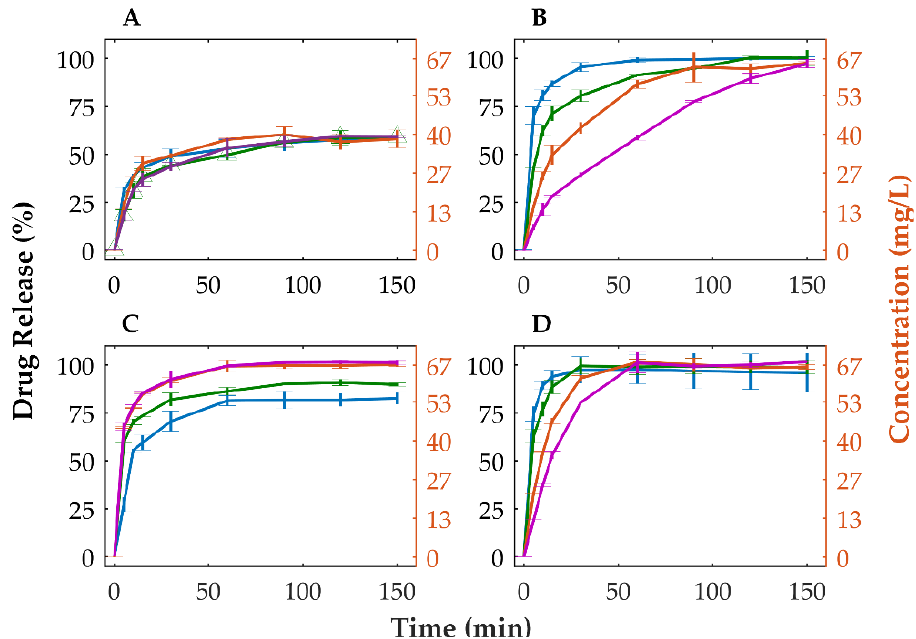
Figure 4. Dissolution profiles of crystalline ( A ) and amorphous OLZ ( B ) in formulation A and crystalline ( C ) and co-amorphous OLZ ( D ) in formulation B. [0 MPa (physical mixtures, blue), 25 MPa (green), 90 MPa (orange) and 155 MPa (purple) tablets].